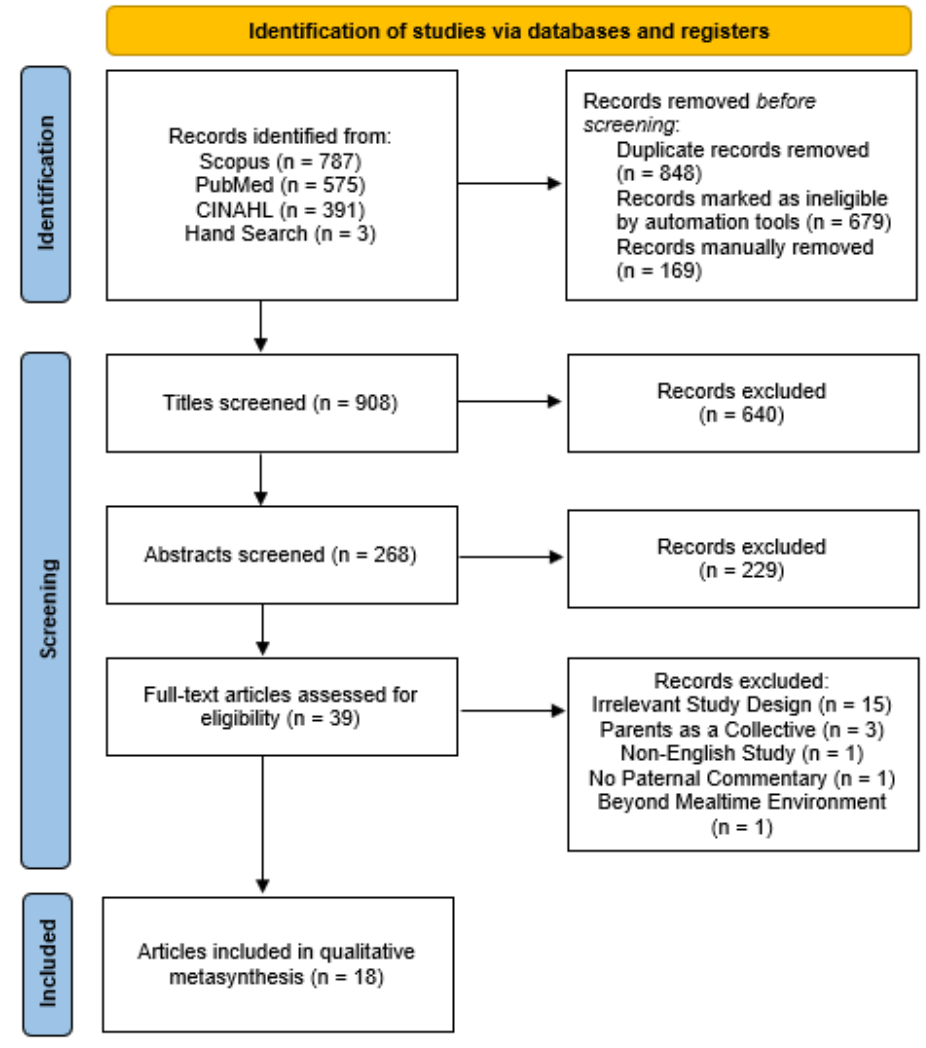
Figure 1. PRISMA